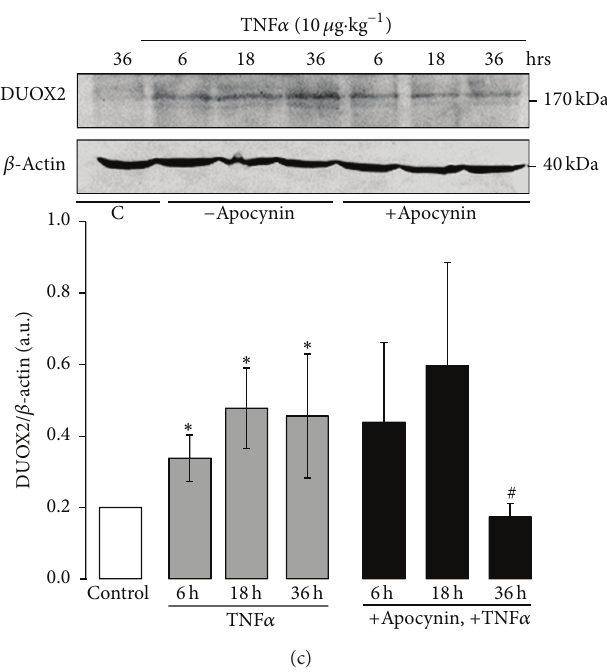
Figure 4: Protein expression of NOX1, NOXA1, NOXO1, and p22 PHOX in the colon of TNF 𝛼 -treated mice: effect of apocynin. (a) Mice were treated with TNF 𝛼 (10 𝜇 g ⋅ kg −1 , ip) in the presence or absence of apocynin (25 mg ⋅ kg −1 , ip) as described in Figure 1(a) (C in the figure is for control untreated mice). Proteins were extracted and 50 𝜇 g was subjected to SDS-PAGE and Western blot as described in Section 2 using NOX1, NOXA1, NOXO1, or p22 PHOX specific antibodies. Mice 𝛽 -actin served as a control for protein loading and transfer; (b) densitometric analysis of the ratio of NOX1, NOXA1, NOXO1, or p22 PHOX protein expression to the total amount of 𝛽 -actin. Data are expressed as means ± S.E.M from 𝑛 = 5 mice in each group. ∗ 𝑃 < 0.05 , ∗∗ 𝑃 < 0.01 , and ∗∗∗ 𝑃 < 0.001 versus control; # 𝑃 < 0.05 , ## 𝑃 < 0.01 , and ### 𝑃 < 0.001 versus TNF 𝛼 . (c) Upper: Western blot analysis of DUOX2 expression using specific antibodies. Mice 𝛽 -actin served as a control for protein loading and transfer. Lower: densitometric analysis of the ratio of DUOX2 protein expression to the total amount of 𝛽 -actin. Data are expressed as means ± S.E.M from 𝑛 = 5 mice in each group. ∗ 𝑃 < 0.05 versus control; # 𝑃 < 0.05 versus TNF 𝛼